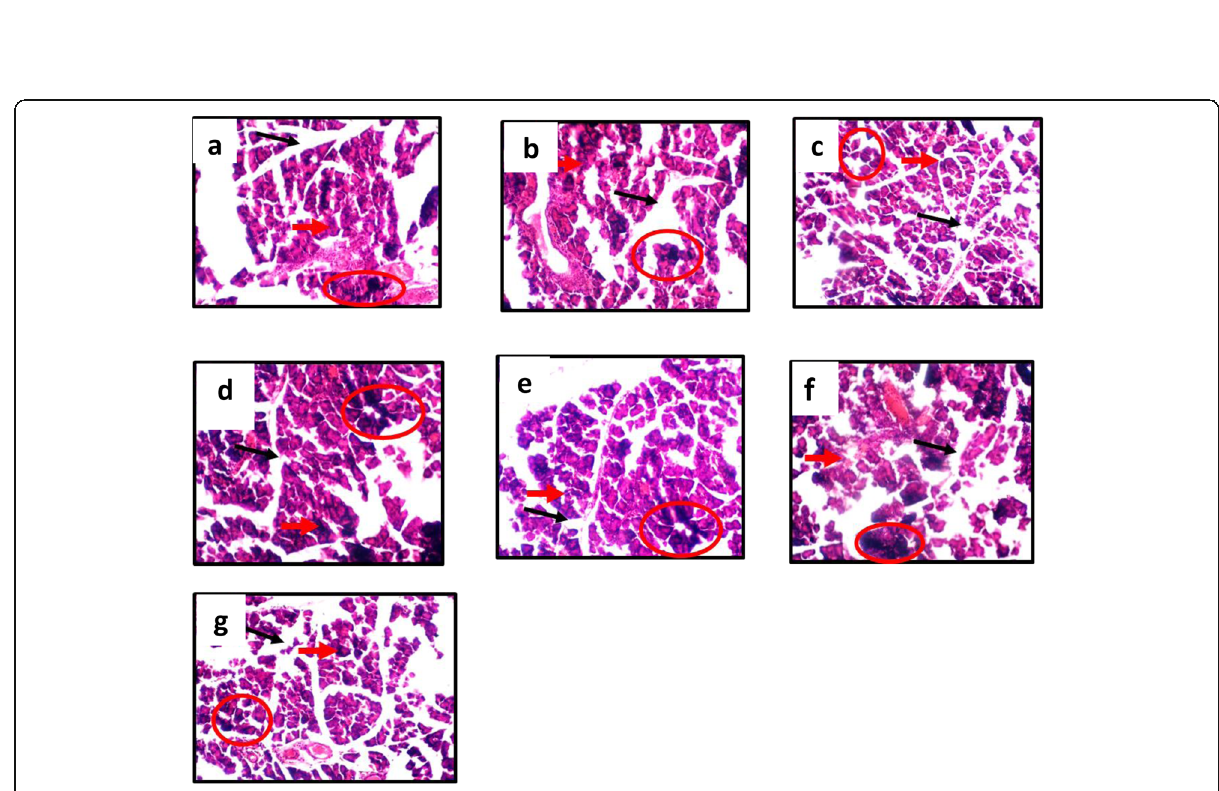
Fig. 2 Representative photomicrograph (× 400, Haematoxylin and eosin stained) of the pancreas of ( a ) control, ( b ) model group; ( c ) Extract treated; ( d ) Glucophage treated; ( e ) Extract + lisinopril treated ( f ) Glucophage + lisinopril treated; ( g ) Lisinopril treated rats